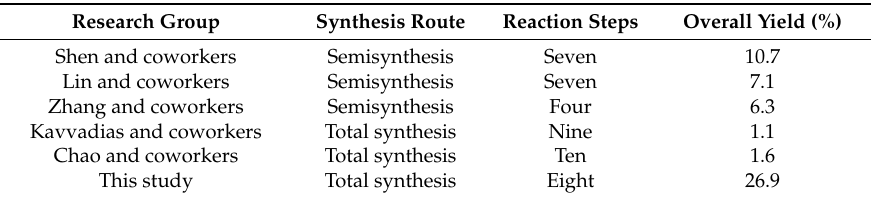
Table 3. Comparison of hispidulin synthesis methods.